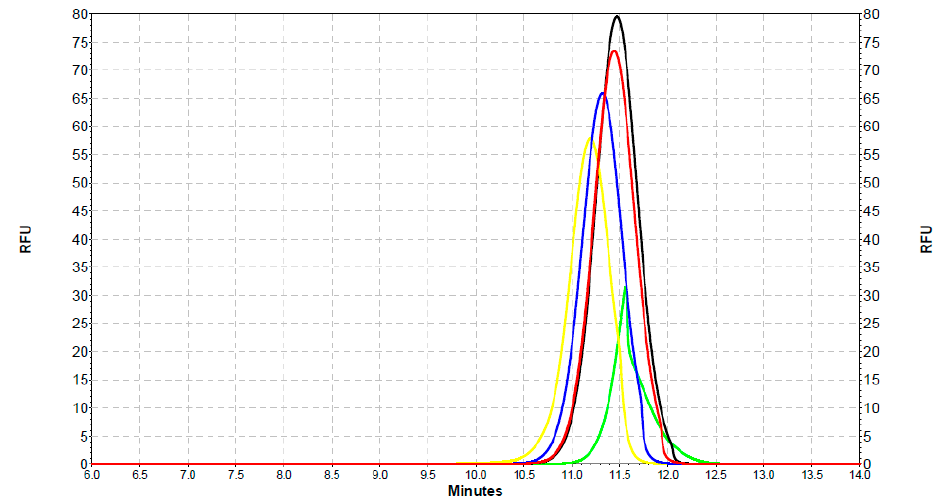
Figure 7. An electrophoretic diagram of separation of G-QDs–SOD complexes using CE with an LIF detector. Color codes: black: G-QDs with SOD (1.2 µg/mL), red: G-QDs with SOD (4 µg/mL), blue: G-QDs with SOD (40 µg/ml), yellow: G-QDs with SOD (400 µg/mL), and light green: G-QDs alone.